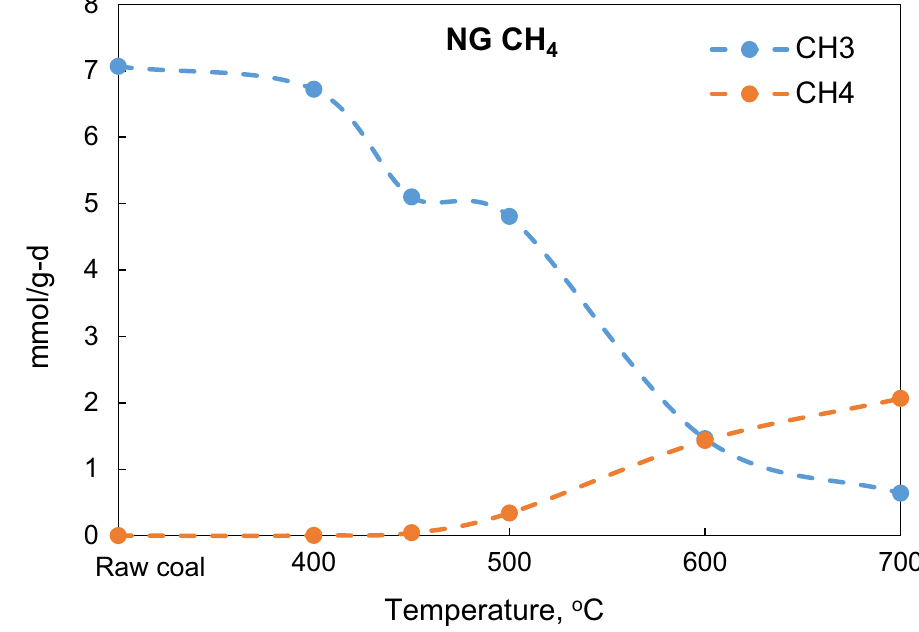
Fig. 8 Integration of CH 4 as a function of temperature and the trends of its relevant functional groups of -CH 3 of coal